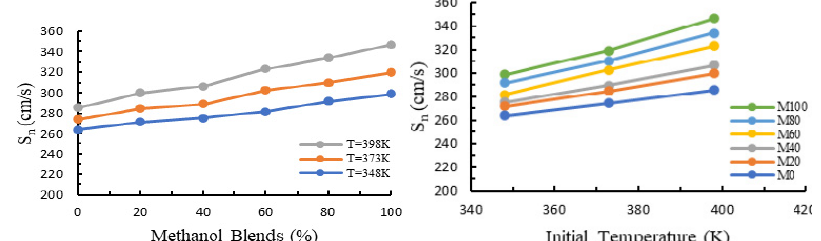
Figure 9. Variation of S n at 20 mm flame radius versus: (a) methanol blending ratios (b) initial